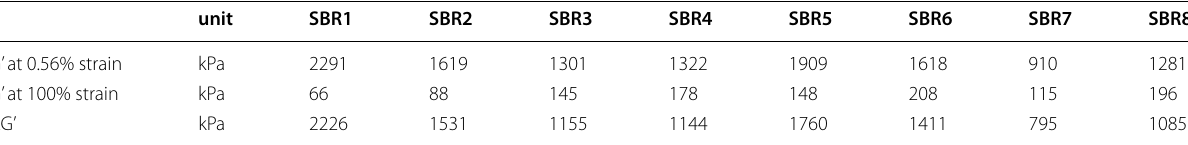
Table 4 Storage moduli at low strain and high strain unit G’ at 0.56% strain